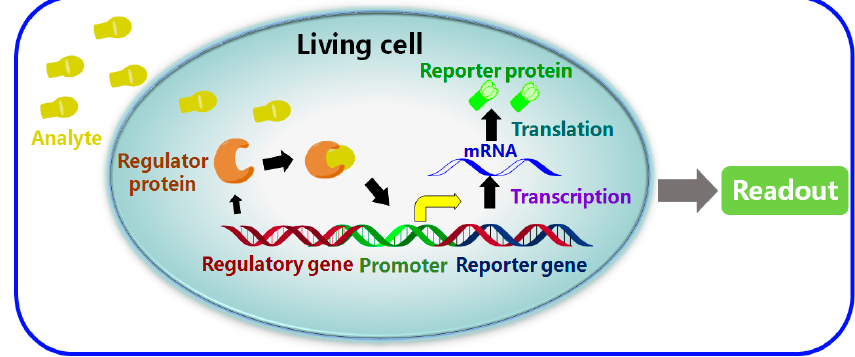
Figure 1. A schematic diagram representing a typical whole cell-based biosensor.